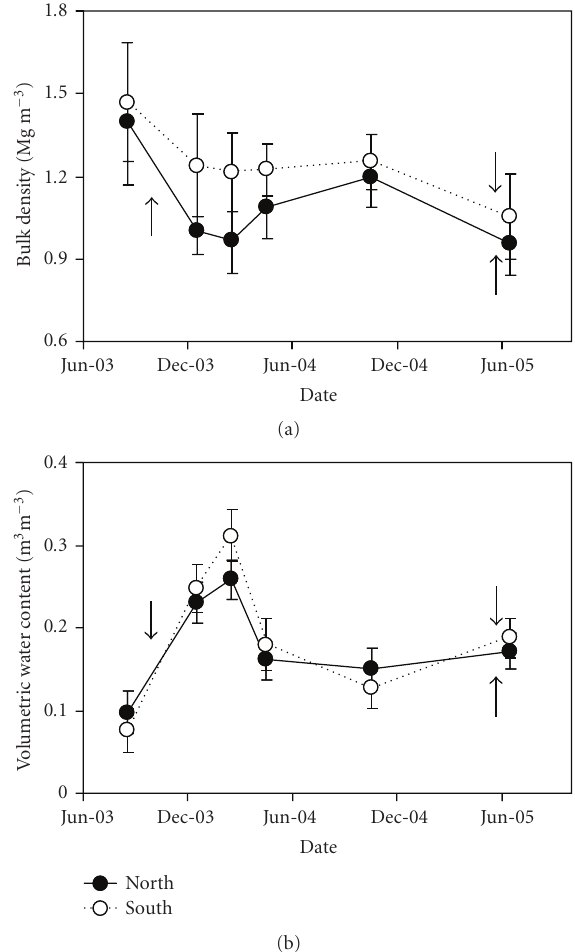
Figure 4: Seasonal changes in bulk density and volumetric water content. Arrows indicate the time of the tillage operations. The north field was converted from no-till to standard tillage in August 2003, while the south field remained under no-till. Both fields were then converted to minimum tillage in May 2005. Bars indicate the standard deviation of the